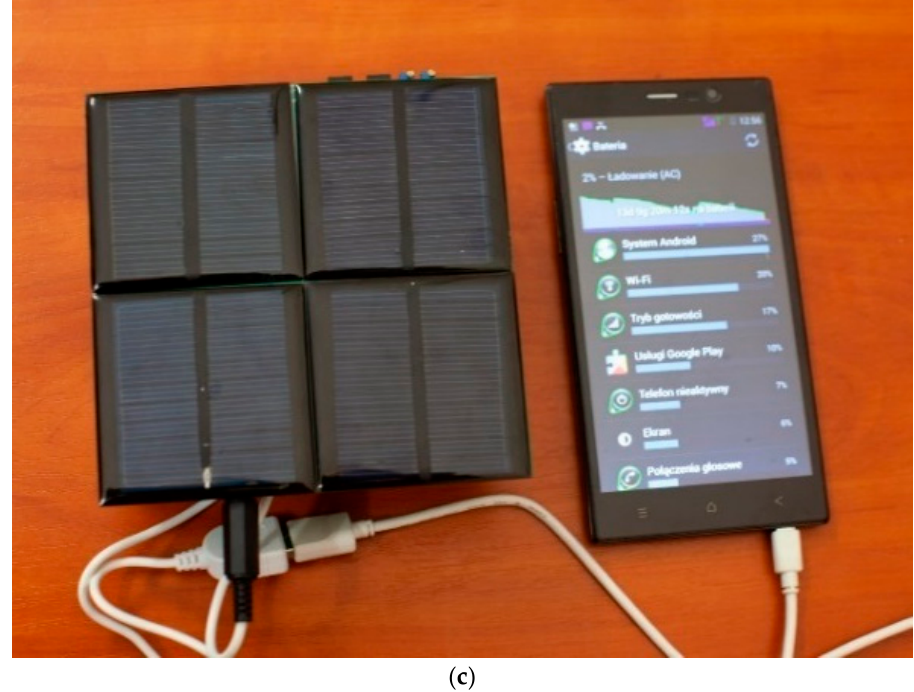
Figure 6. Images of voltage and current values during charging ( a ) the supercapacitor module and after charging ( b ) the supercapacitor module together with an example of charging a mobile phone using our energy storage system ( c ).